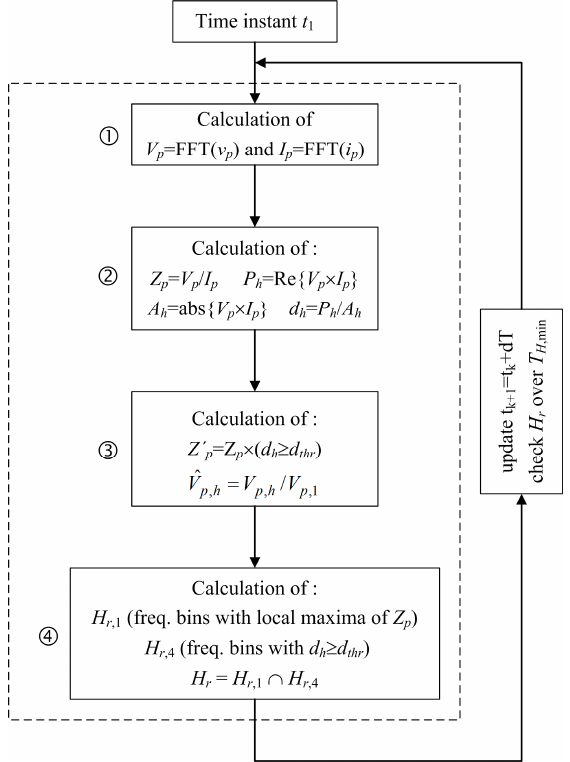
Figure 7. Flowchart of the harmonic resonance detection method and data structures used to support estimate of computational and storage complexity.